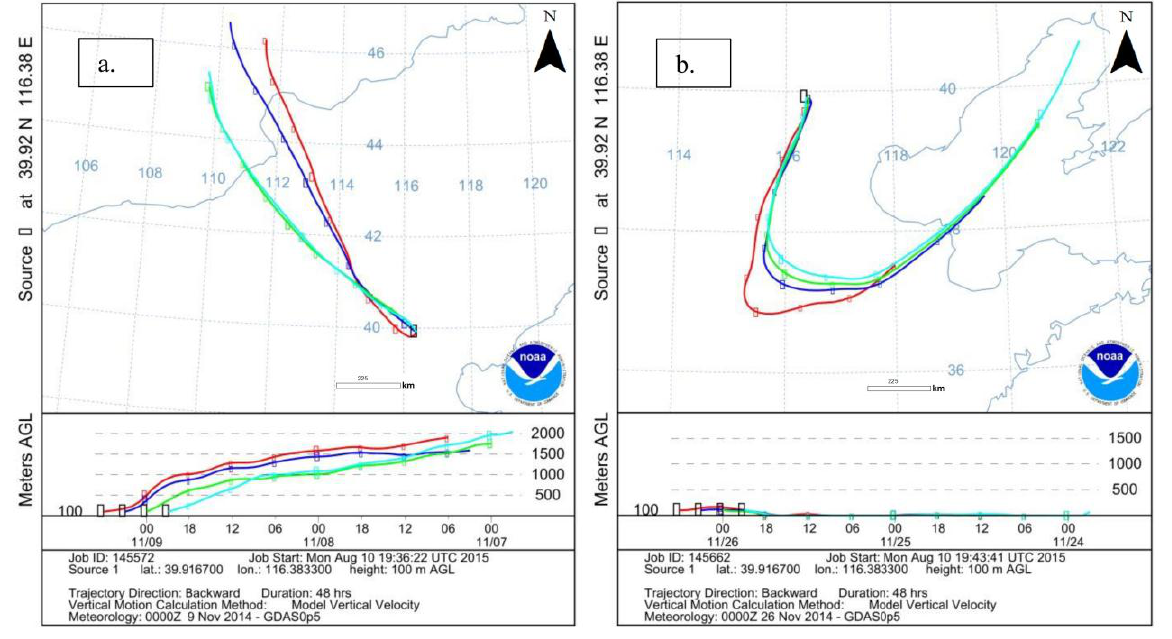
Figure A1. Back trajectory analysis using Beijing as the source; ( a ). 9 November 2014; ( b ). 26 November